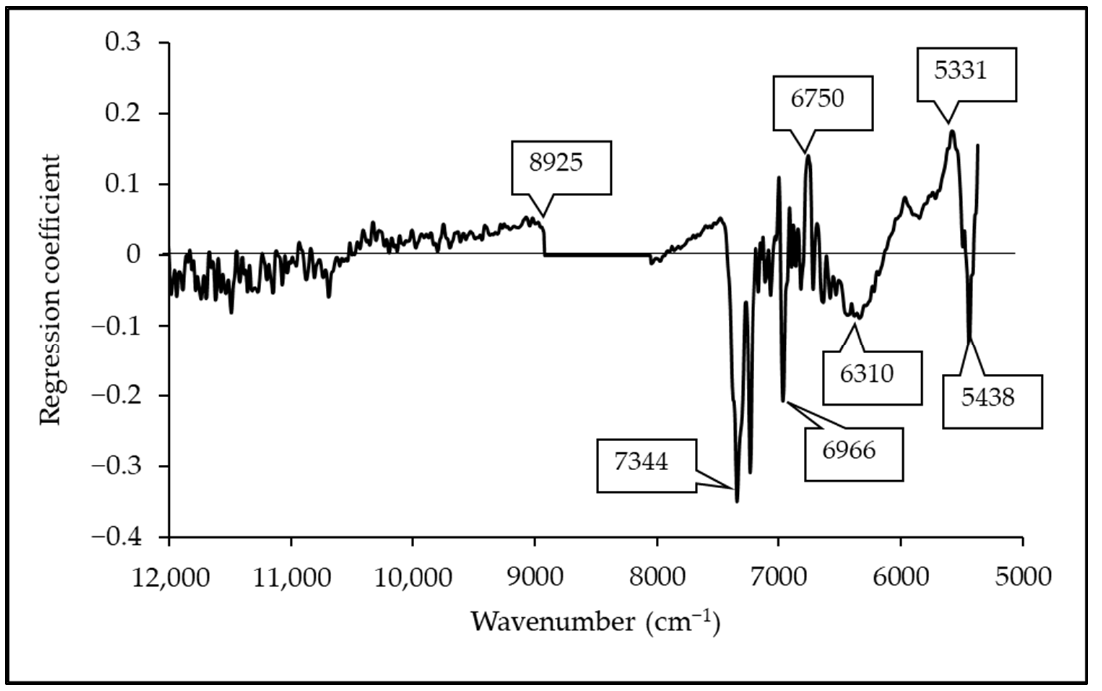
Figure 6. Regression coefficient plot of the PLSR model for TA prediction in mango purée.